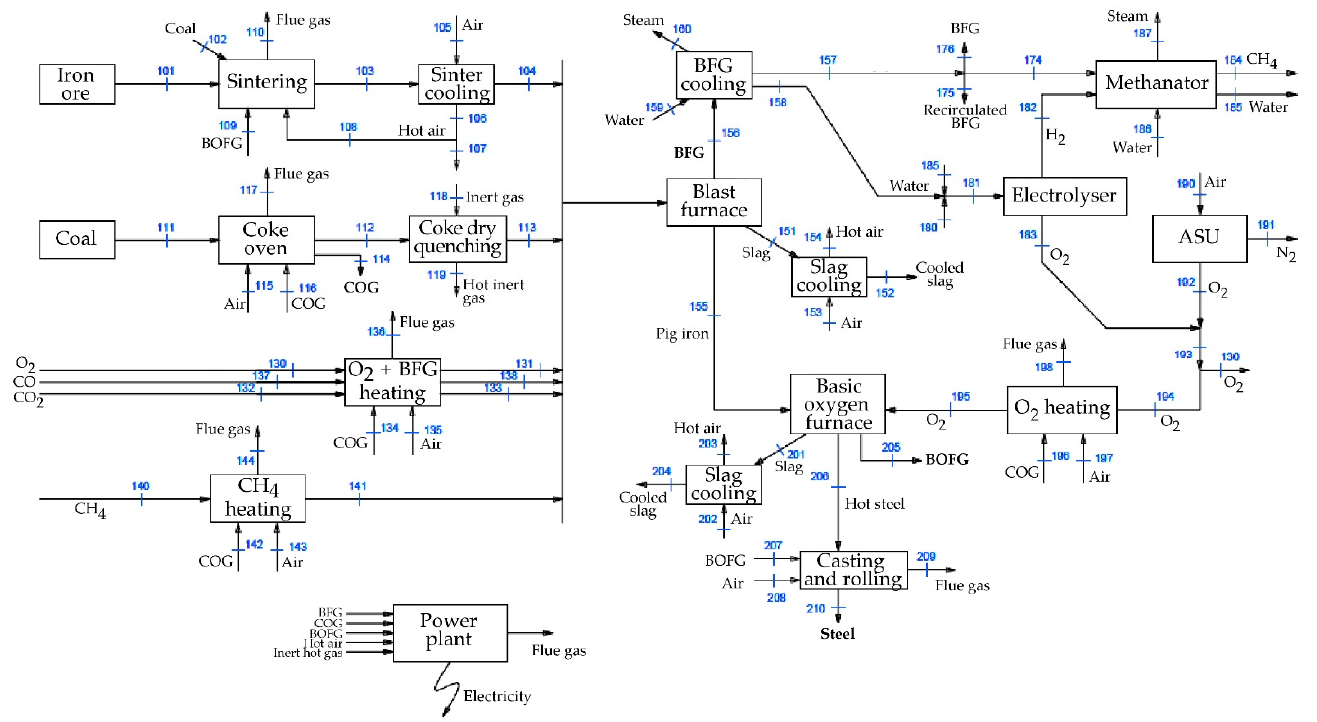
Figure 3. Block diagram of the integration of power-to-methane in ironmaking with oxy-fuel combustion and TGR (Case 1).